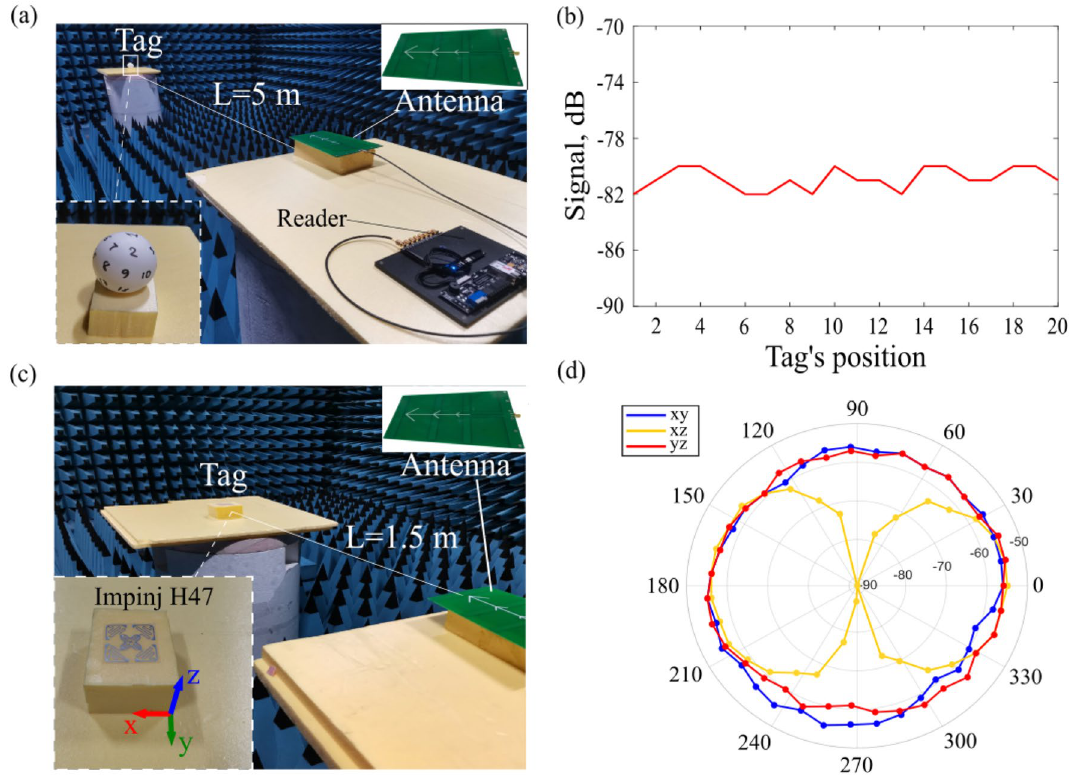
Figure 4. ( a ) Photo of the experimental setup with our tag in an anechoic chamber. ( b ) The received signal power as a function of the tag’s orientation in space (marks are in the inset to panel ( a )). ( c ) Photo of the experimental setup with Impinj H47 tag in an anechoic chamber. ( d ) Angular diagram of the received signal power in xy, xz and yz coordinate